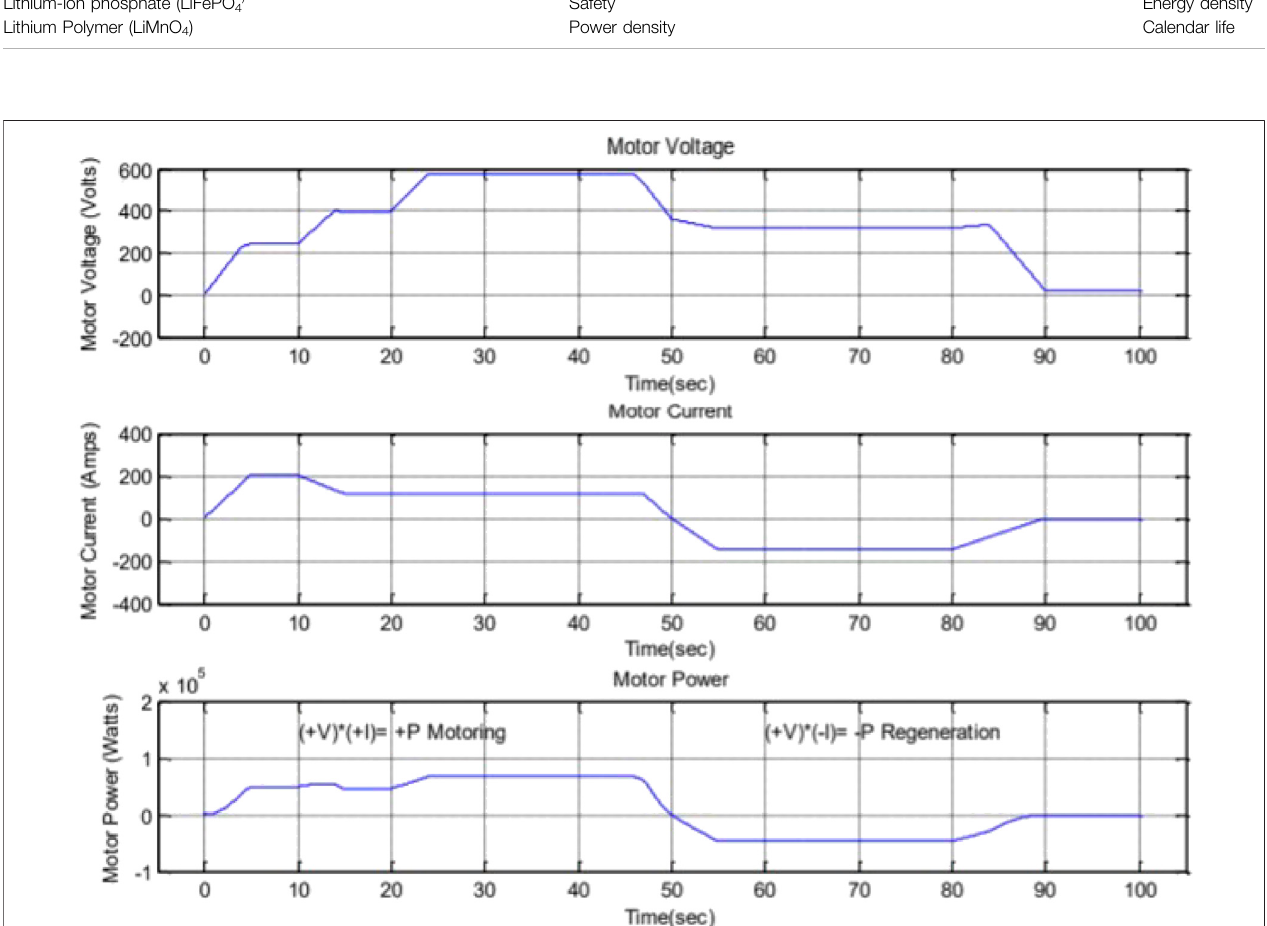
FIGURE 11 | Motor voltage, current and